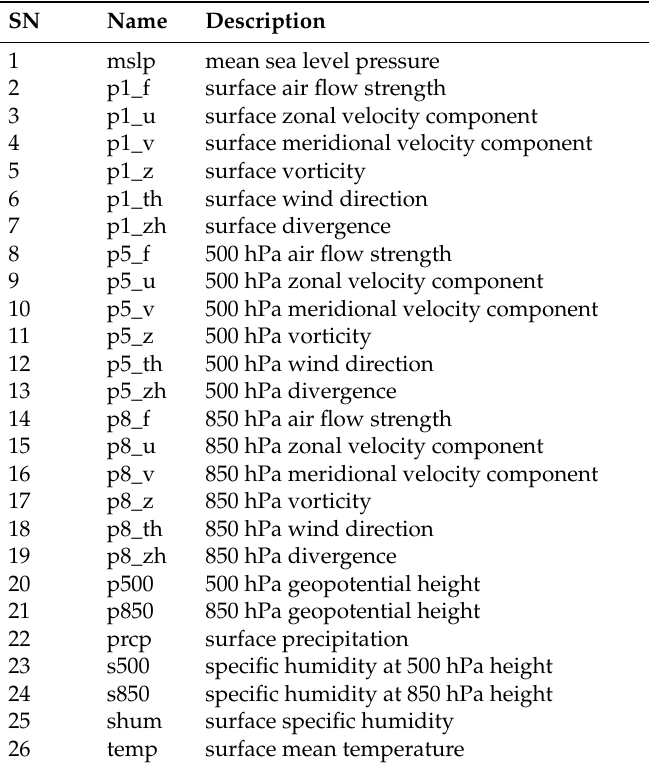
Table 1. Predictor variables of the Global Climate Model (GCM) and the National Center for Environmental Prediction (NCEP). SN